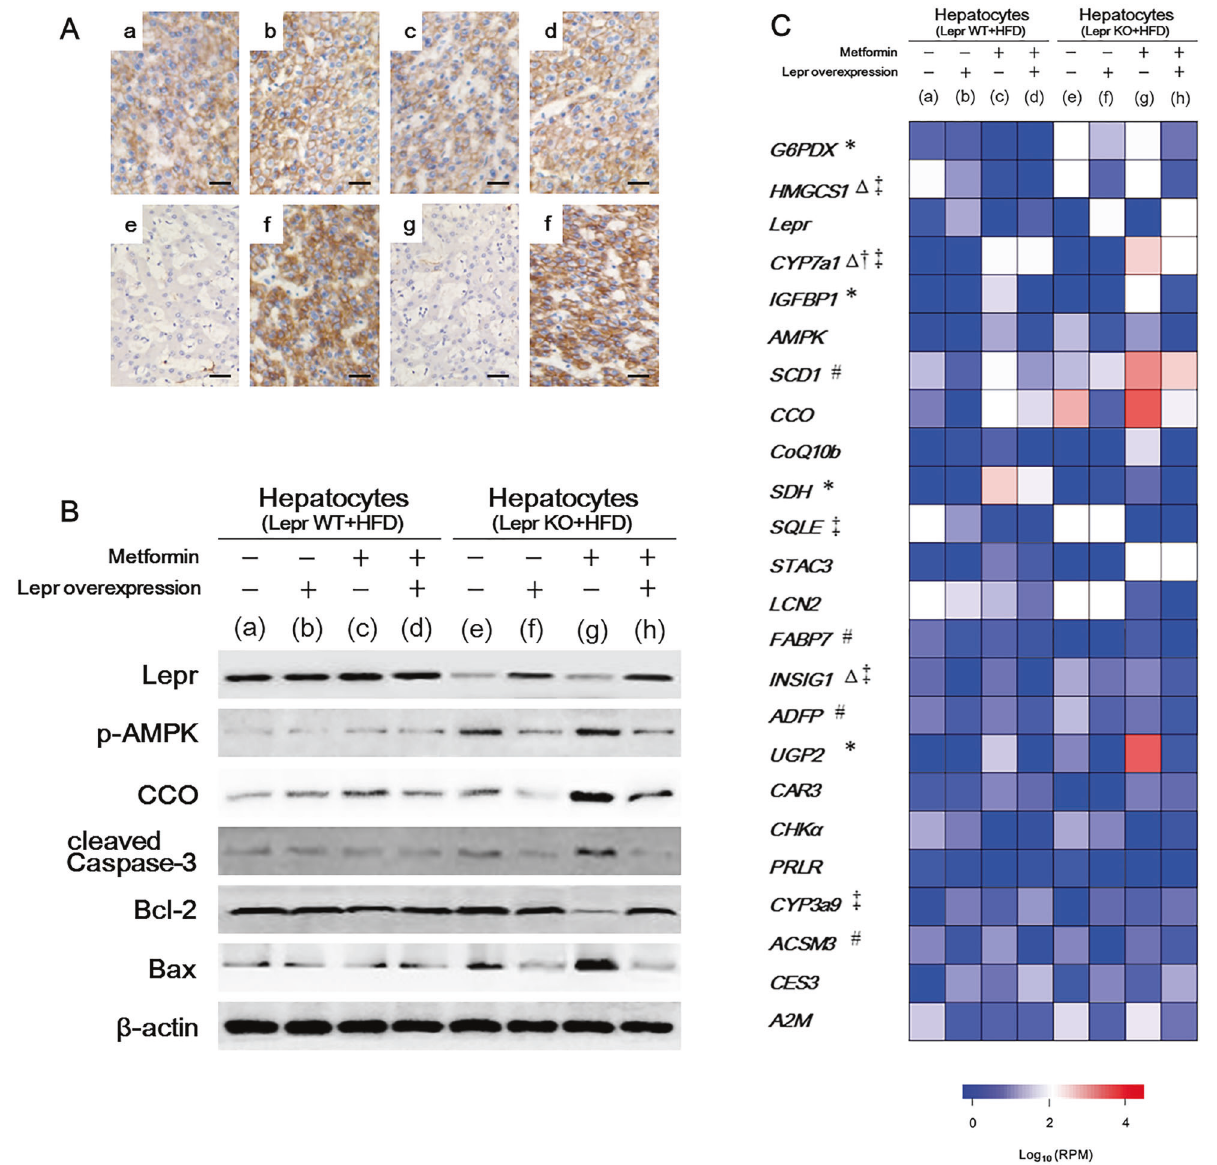
Fig. 7 Leptin receptor (Lepr) overexpression can rescue hepatocytes from the hyper-activation of glucose metabolism-involved genes, containing G6PDX , IGFBP1 , SDH and UGP2 . A We conducted overexpression of Lepr in hepatocytes isolated from high-fat diet (HFD)-fed Lepr- knockout (Lepr-KO) rats and Lepr wild type (Lepr WT) rats. This was followed by immunostaining on Lepr at 96 h post transfection in both the presence and the absence of metformin. Scale bars, 30 μ m. a, b hepatocytes isolated from HFD-fed Lepr WT rats were transfected with Lepr construct (b) or control vector (a) in the absence of metformin; c-d, hepatocytes isolated from HFD-fed Lepr WT rats were transfected with lepr construct (d) or control vector (c), followed by metformin treatment for 96 h; e-f, hepatocytes isolated from HFD-fed Lepr-KO rats were transfected with Lepr construct (f) or control vector (e) in the absence of metformin; g-h, hepatocytes isolated from HFD-fed Lepr-KO rats were transfected with Lepr construct (h) or control vector (g), followed by metformin treatment for 96 h. B Western blotting analysis for a-h in A . C Single-cell RNA sequencing for a – h in A (the 24 genes with the widest disparities between metformin-treated Lepr WT hepatocytes and Lepr-KO hepatocytes). n = 12. *Glucose metabolism-involved genes; # Fatty acid metabolism-involved genes; Δ Cholesterol metabolism- involved genes; † Bile acid metabolism-involved genes; ‡ Sterol metabolism-involved genes. G6PDX, glucose-6-phosphate dehydrogenase X- linked; HMGCS1, 3-hydroxy-3-methylglutaryl-coenzyme A synthase 1 swqazXEDwseqadxzLepr, leptin receptor; CYP7a1, cytochrome P450 (family 7, subfamily a, polypeptide 1); IGFBP1, Insulin-like growth factor-binding protein 1; AMPK, adenosine monophosphate (AMP)-activated protein kinase; SCD1, Stearoyl-coenzyme A desaturase 1; CCO, cytochrome C oxidase; CoQ10b, Coenzyme Q10 homolog B; SDH, serine dehydratase; SQLE, Squalene epoxidase; STAC3, SH3- and cysteine-rich domain 3; LCN2, lipocalin 2; FABP7, fatty acid-binding protein 7 (brain); INSIG1, insulin-induced gene 1; ADFP, adipose differentiation-related protein; UGP2, uridine diphosphate (UDP)-glucose pyrophosphorylase 2; CAR3, carbonic anhydrase 3; CHK α , choline kinase α ; PRLR, prolactin receptor; CYP3a9, cytochrome P450, family 3, subfamily a, polypeptide 9; ACSM3, acyl-CoA synthetase medium-chain family member3; CES3, carboxylesterase 3; A2M, alpha-2-macroglobulin.